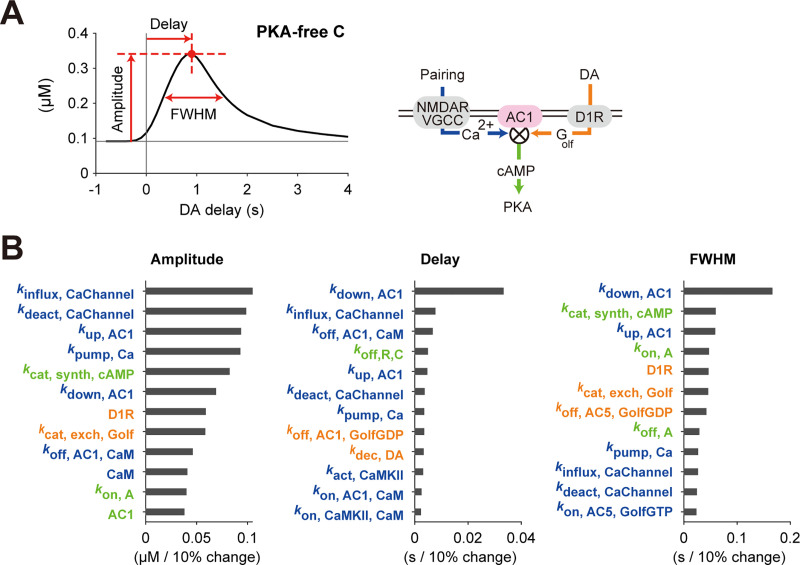
Sensitivity analysis of the D1 RP model.(A) Target characteristics of the parameter sensitivity analysis. The changes of amplitude, delay, and FWHM of the time window were quantified against ±10% changes of each of the model parameters, i.e., kinetic constants and molecular concentrations. (B) Top twelve parameters sensitive to the amplitude, delay and FWHM. Parameters regarding Ca2+, DA, and PKA signals were denoted by blue, orange, and green, respectively. When a model parameter was changed by −10% and +10%, the corresponding changes of a target characteristic were obtained as α1 and α2, respectively, and the average of their absolute values, i.e., (|α1|+|α2|)/2 was plotted. Sensitivities against all parameters were shown in S2 Fig.